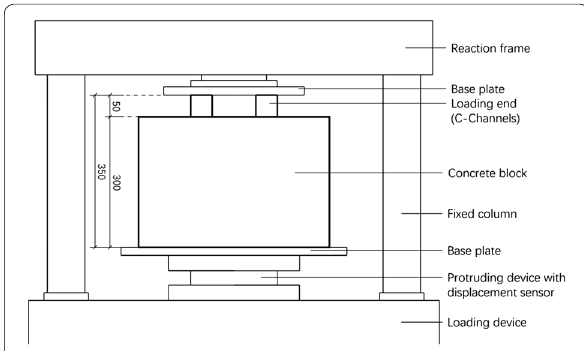
Fig. 3 Test setup (unit: